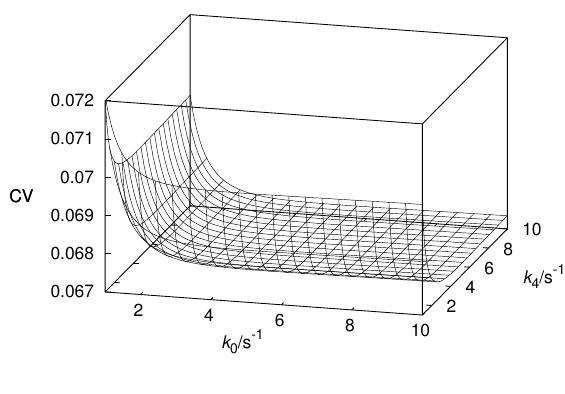
Fig. 2. CV plotted vs k 0 and k 4 with k 1 = 0 . 5 s − 1 , k 2 = 10 s − 1 , k 3 = 10 s − 1 and n = 200 nt .